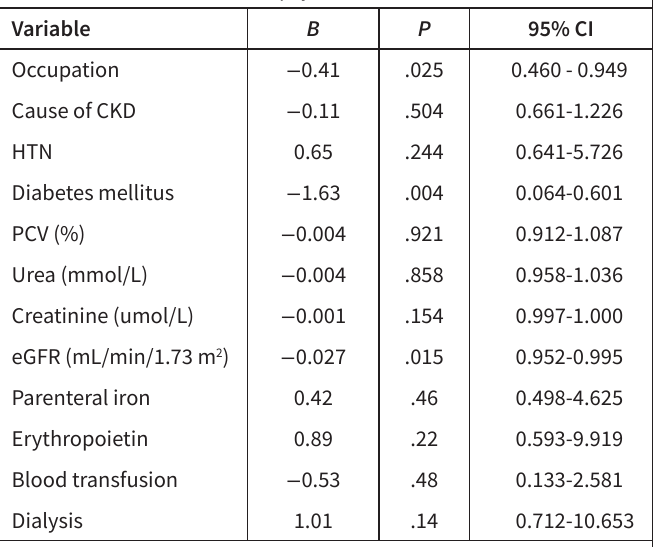
Table 6. Predictors of Neuropsychiatric